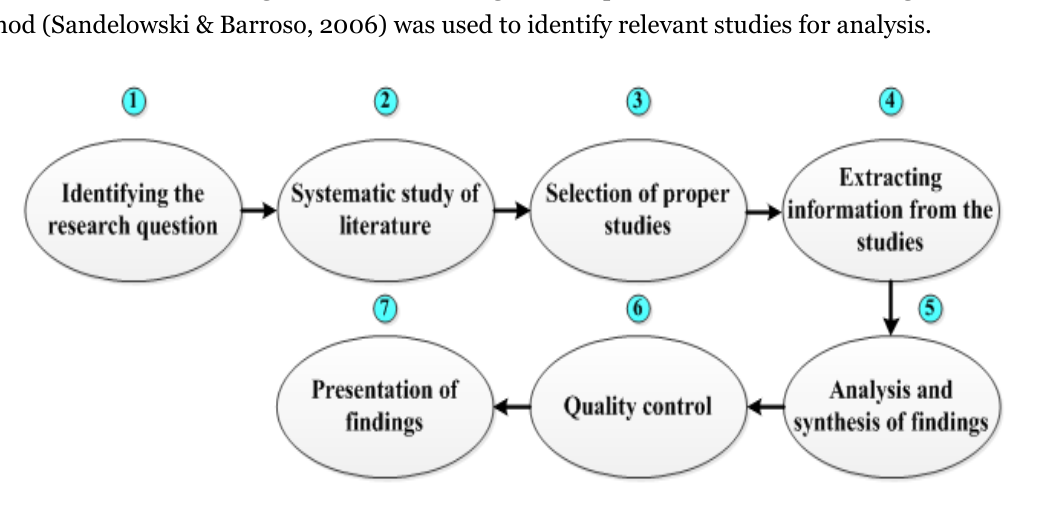
Figure 1. Research synthesis steps. Adapted from Handbook for synthesizing qualitative research , by M. Sandelowski and J. Barroso, 2006, Springer Publishing